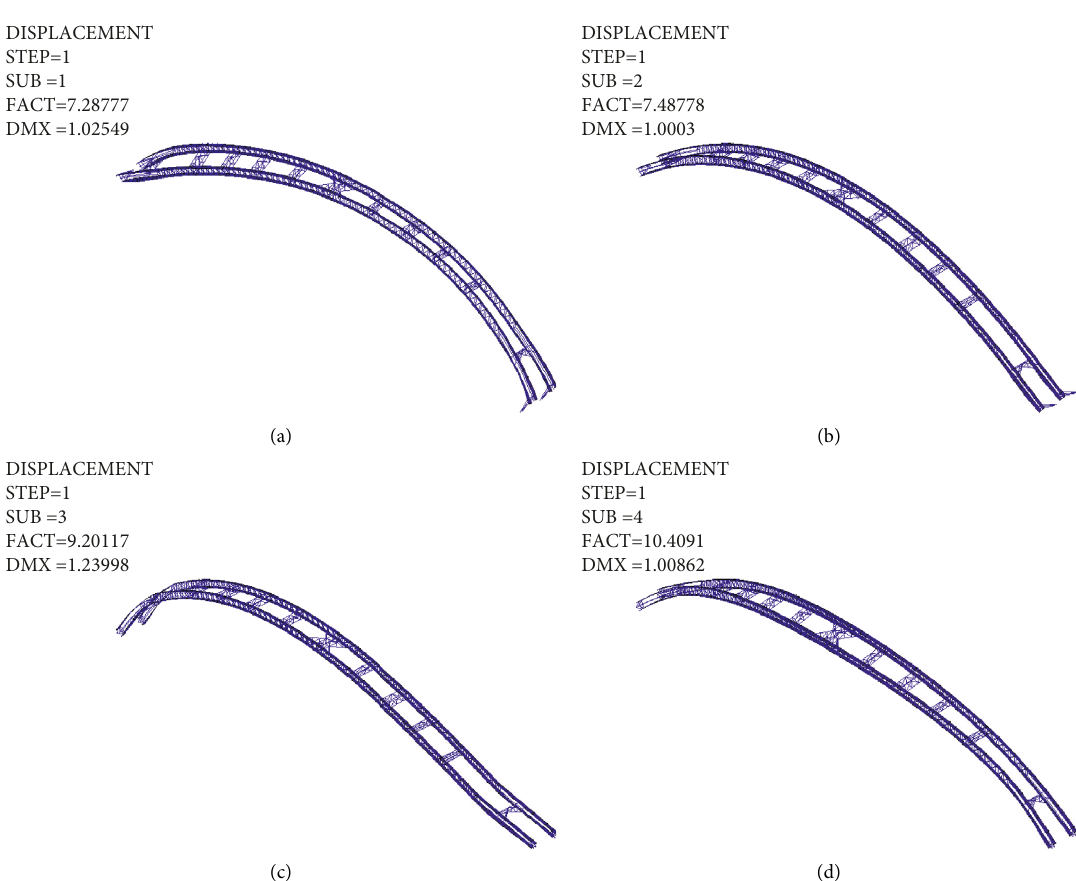
Figure 27: Stability calculation: (a) the first-order instability mode, (b) the second-order instability mode, (c) the third-order instability mode, and (d) the fourth-order instability